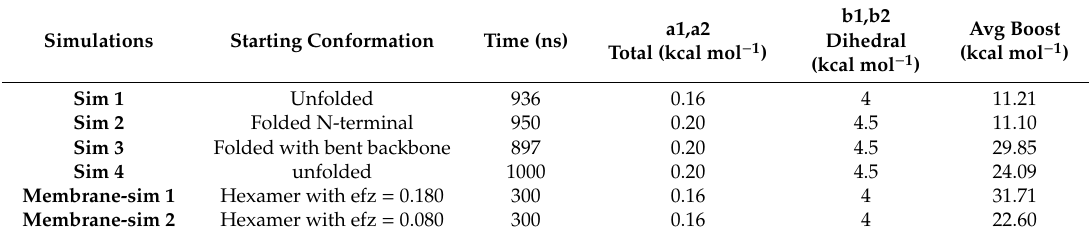
Table 1. Summary of various accelerated molecular dynamics